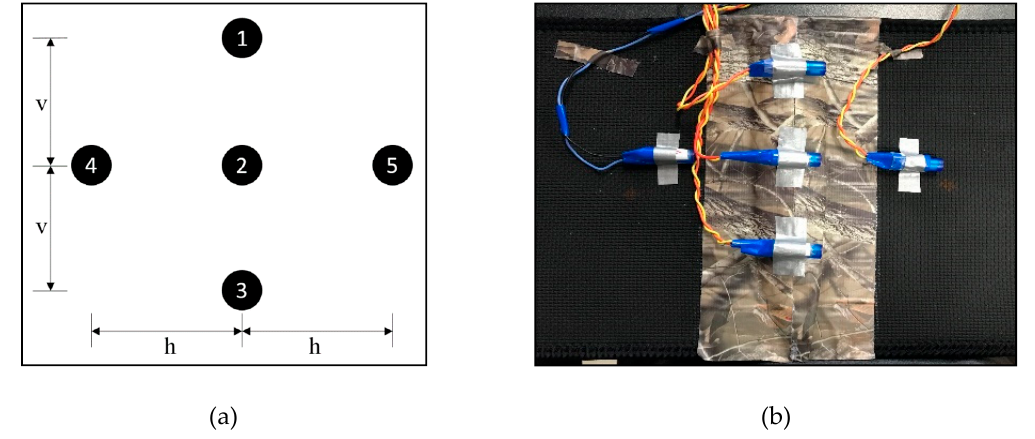
Figure 5. General arrangement of vibration motors for spacing study: ( a ) theoretical arrangement of vibration motors; ( b ) vibration motors embedded on waist belt.